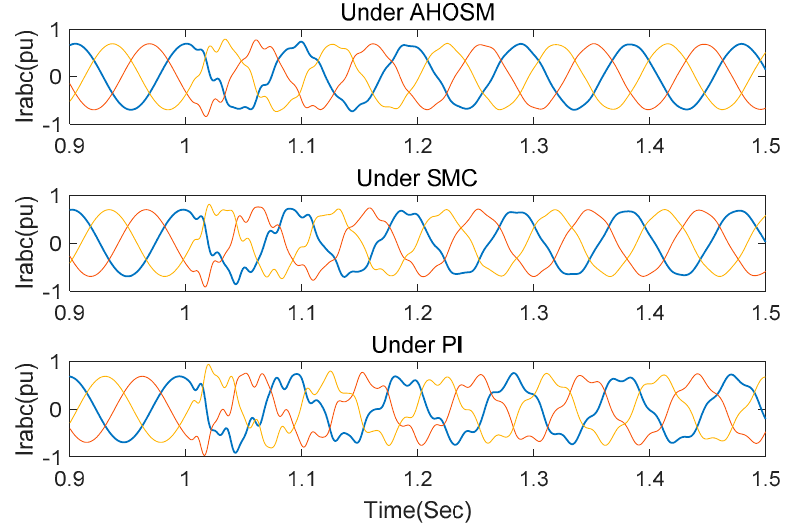
Figure 15. Responses of current rotor under three control methods with series ‐ compensated level 30% and wind speed 11 m/s.